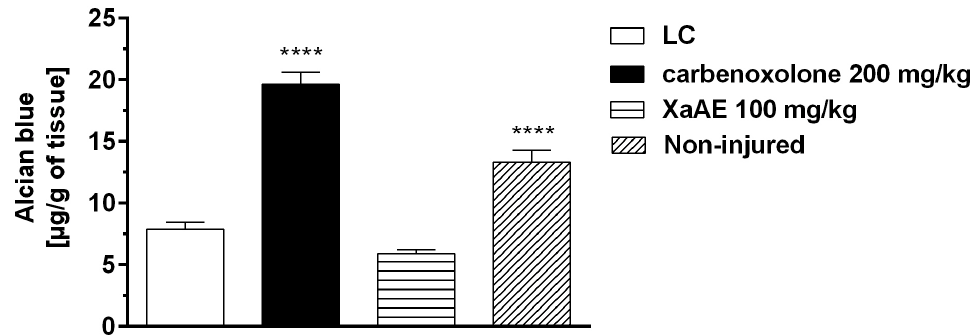
Figure 11. Effect of the aqueous extract from X. americana (XaAE) stem bark on the gastric mucus content after pylorus ligation in Wistar rats. The animals received 0.9% NaCl solution orally (lesioned control, LC, 10 mL/kg), carbenoxolone (orally) or XaAE (orally). The non-lesioned group received no treatment. Results were expressed as mean ± SEM (6–7 animals/group). Statistically different when compared to the lesioned control group (ANOVA, followed by Dunnett’s multiple comparisons test, **** p < 0.0001).